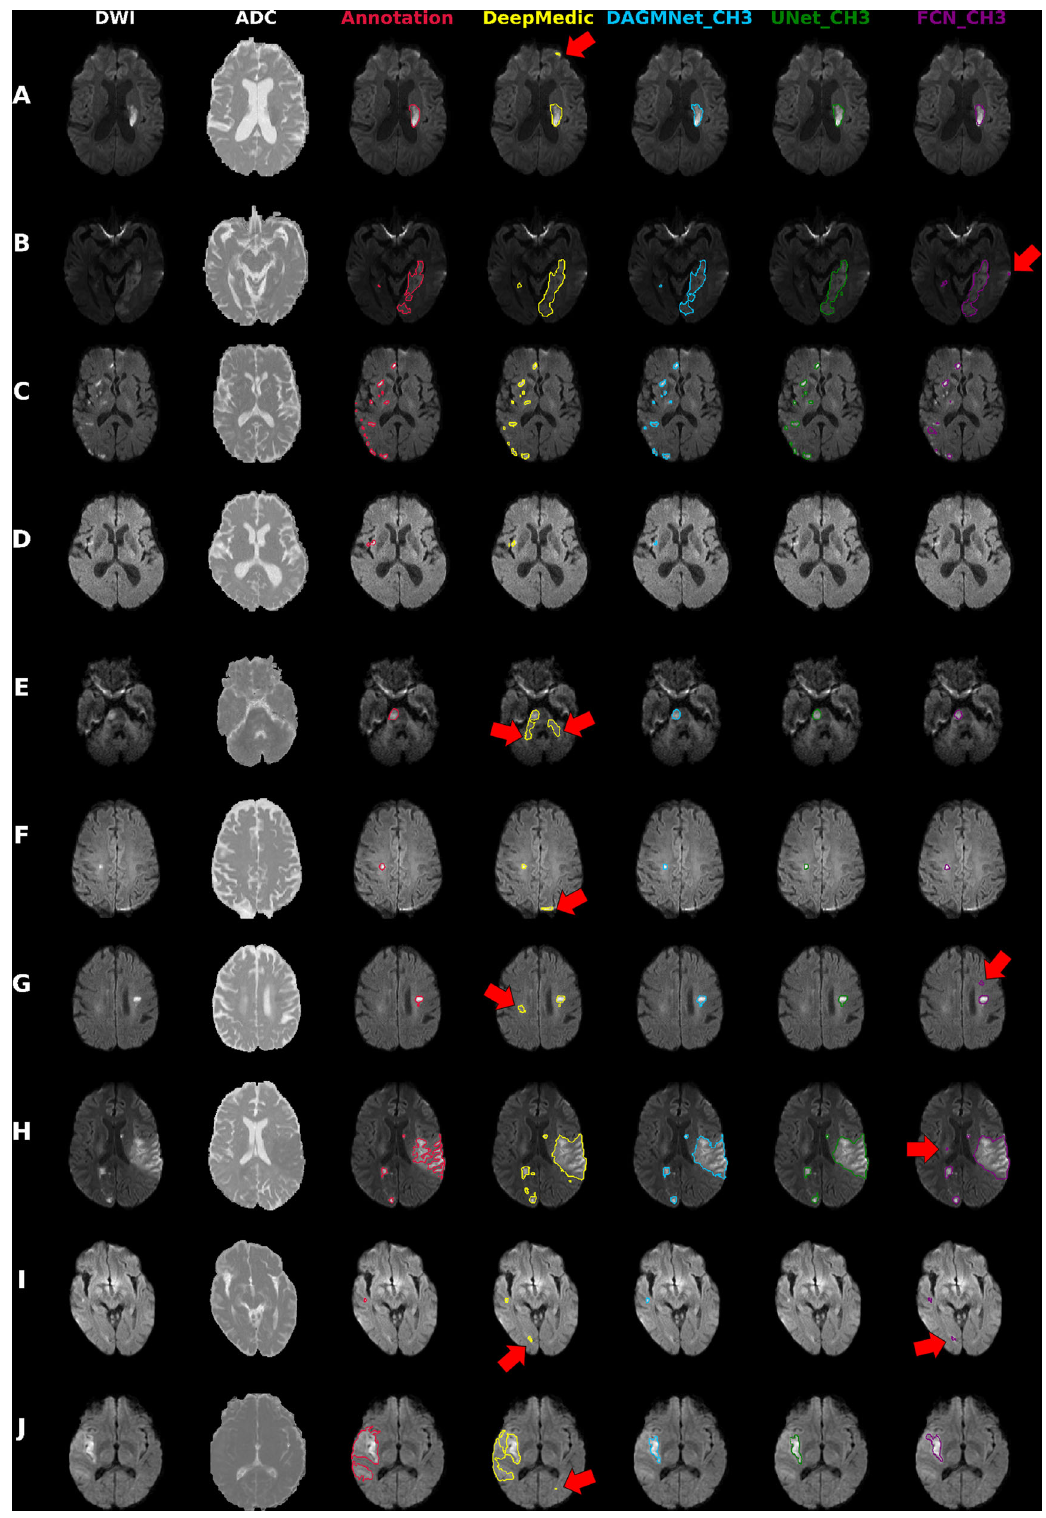
The automated DL models (our proposed DAGMNet, Deep- Medic, and Unet) achieved comparable lesion quanti fi cation performance to our experienced evaluators, because their agree- ment with human delineation was close to the interevaluator agreement (Dice: 0.76 ± 0.14, as described in Methods). Among all the tested models, our proposed model showed the highest